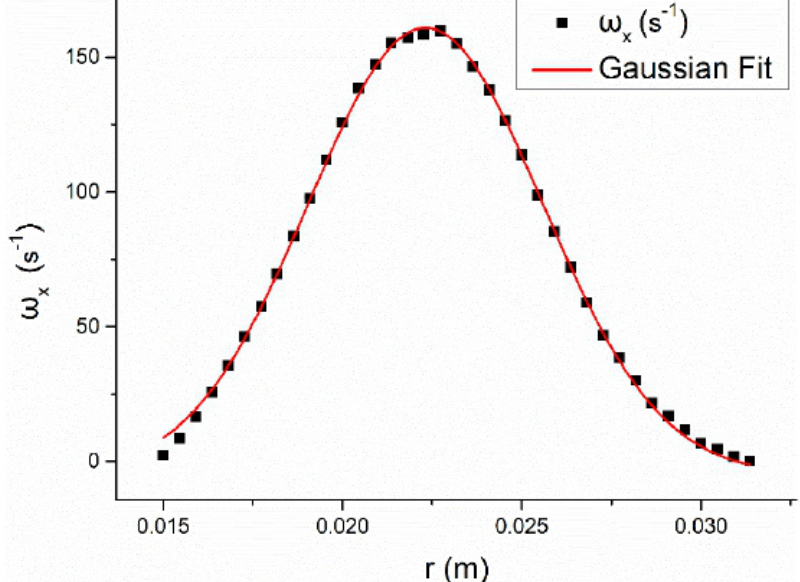
Figure 1. The sampling points of axial vorticity obey Gaussian